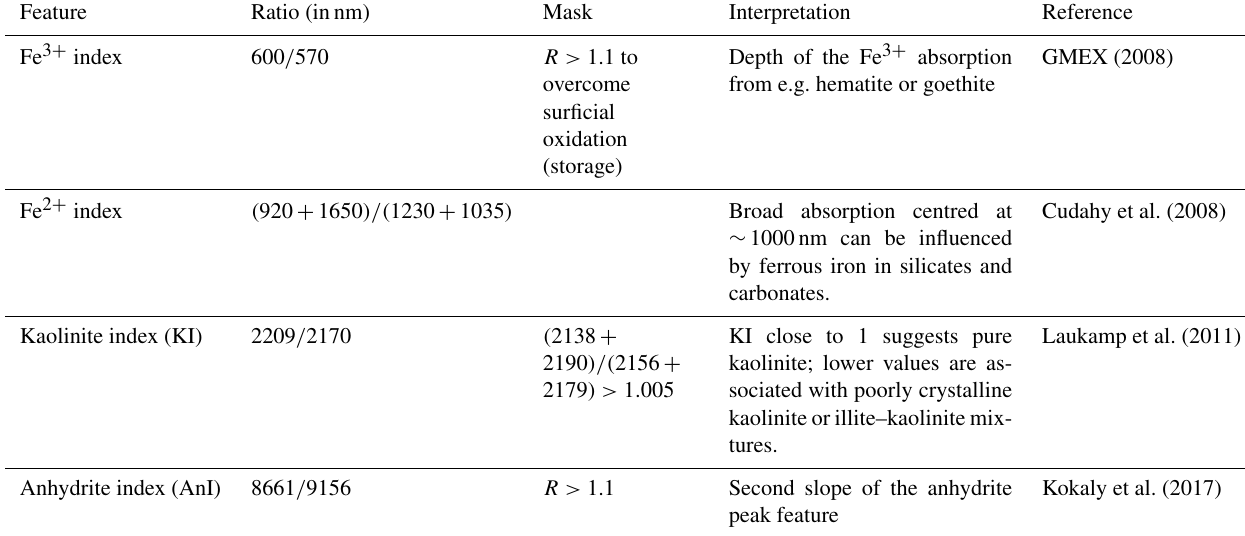
Table 2. Spectral indices for relevant proxies in the Kupferschiefer and its host rock succession at the Spremberg–Graustein deposit.